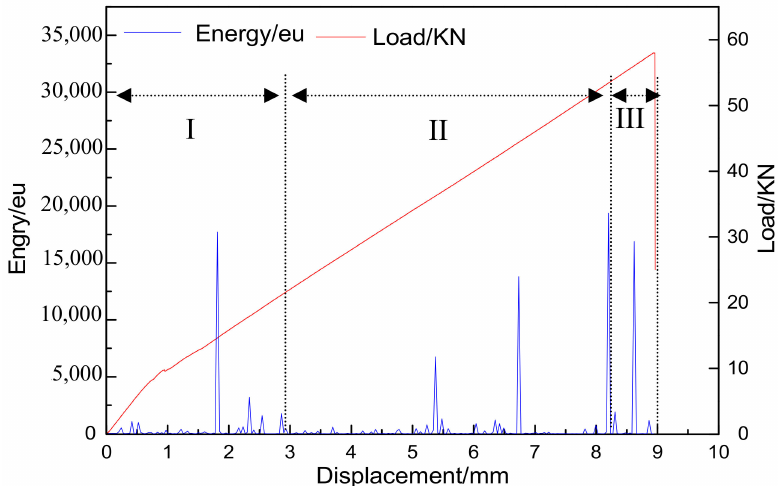
Figure 6. Change in the load–displacement curve corresponding with the AE signal energy parameter of specimen